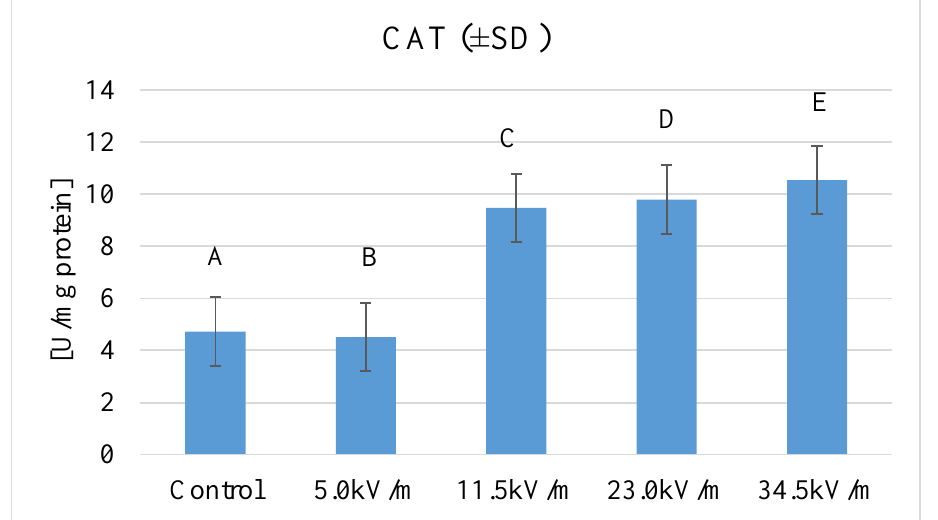
Figure 2. Catalase (CAT) activities in honeybee hemolymph after exposure to the E-field (50 Hz and different intensities). Details as in Figure 1. Statistical differences between the mean values for groups are marked with different letters. Different letters mean the difference is at the p - value ≤ 0.05 significance level.